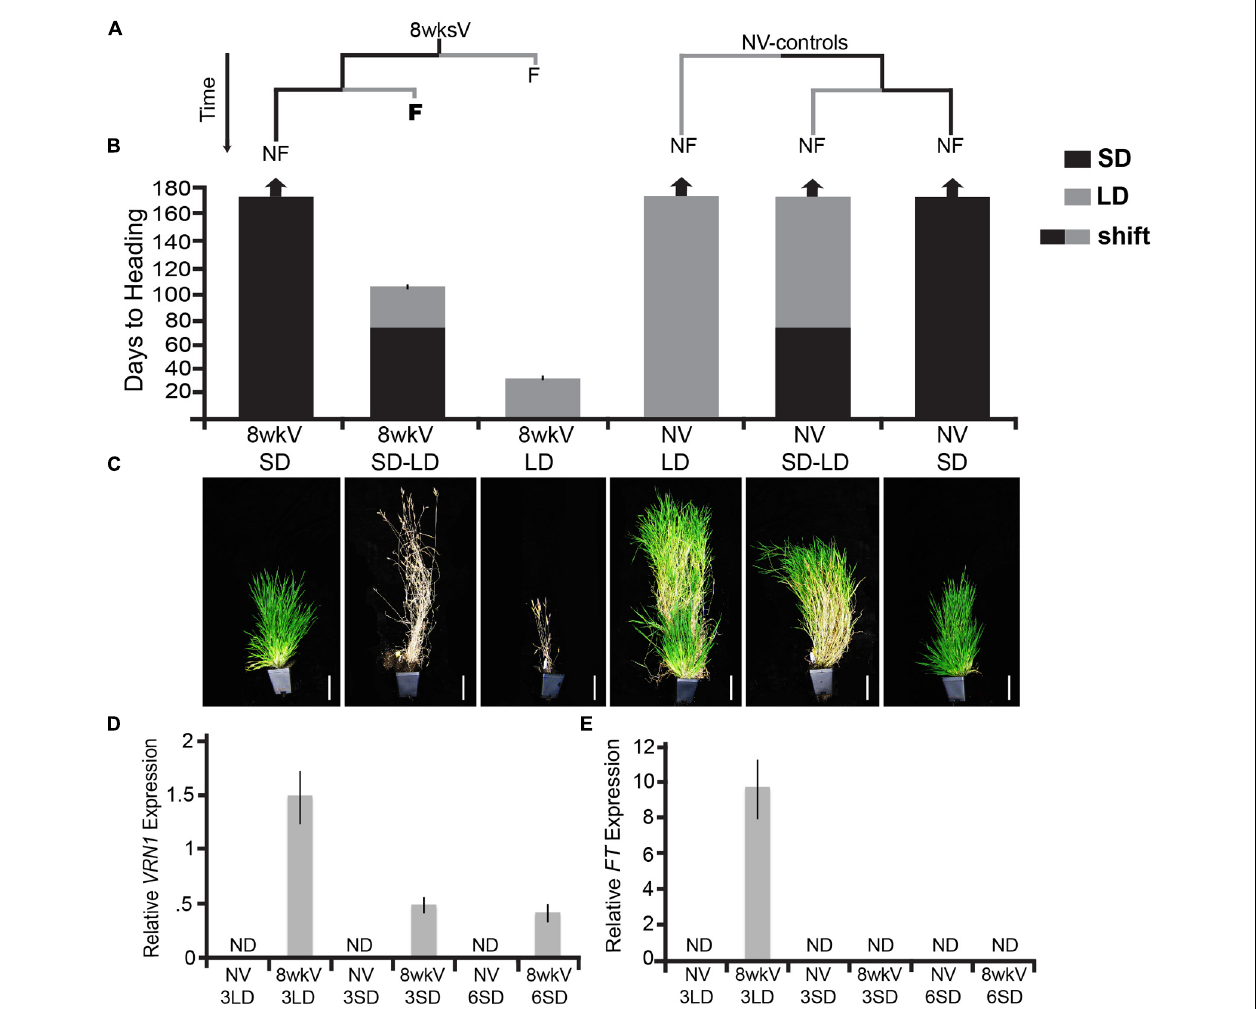
70 days followed by a shift into LD (SD–LD). Bars represent the days to heading average of six plants (experiment was repeated with similar results). (C) Photographs of representative plants at the end of experiment. Plants were grown and scored as described in Ream etal. (2014). Scale bar = 9 cm. (D,E) VRN1 and FT expression in a newly expanded 3 rd leaf and 6 th leaf of Bd29-1. Imbibed seeds in soil were exposed to either a saturating cold treatment (5 ◦ C for 8 weeks) or no cold. At the end of cold treatment, non-vernalized and cold-treated plants were grown in SD and LD for ∼ 3 weeks (3LD, 3SD) and SD for an additional ∼ 6 weeks (6SD) at 22 ◦ C during the light phase and 18 ◦ C during the dark phase until plants reached the third leaf stage and the sixth leaf stage (Note vernalized 29-1 in LD had flowered by 5 weeks so did not sample 6LD). VRN1 and FT transcript levels were determined by RT-qPCR as described in Ream etal. (2014) and normalized to UBIQUITIN-CONJUGATING ENZYME18 . ND denotes no expression detected. Bars represent the average of four biological replicates ± standard deviation (three leaves per